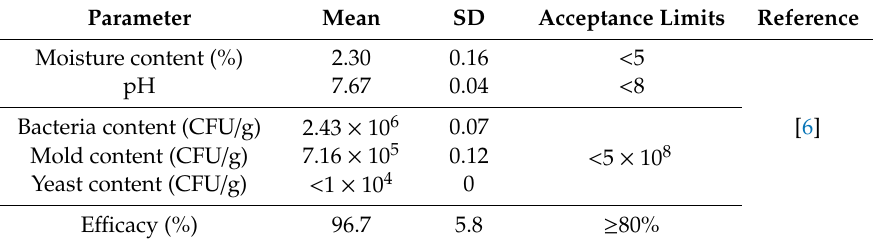
Table 3. Quality parameters of mixture M3 (97.5% of SfCOL + 2.5% of VG008) formulated as WP.